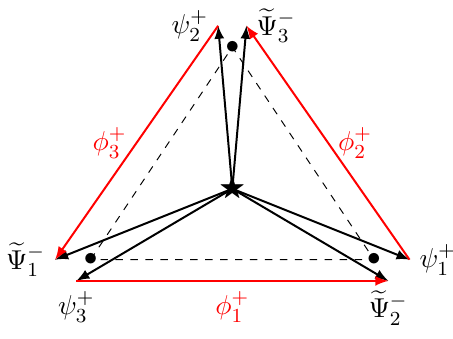
Figure 21. Chiral inter-brane fermions (cid:9) (cid:11); (cid:3) 0 and e (cid:9) (cid:11); (cid:3) 0 linking C [( N; 0)] with a point-brane D , which is represented by F . Their chirality is indicated by the sign (cid:6) , which is inherited from the Weyl chamber. Red arrows correspond to maximal Higgs (cid:30) + j